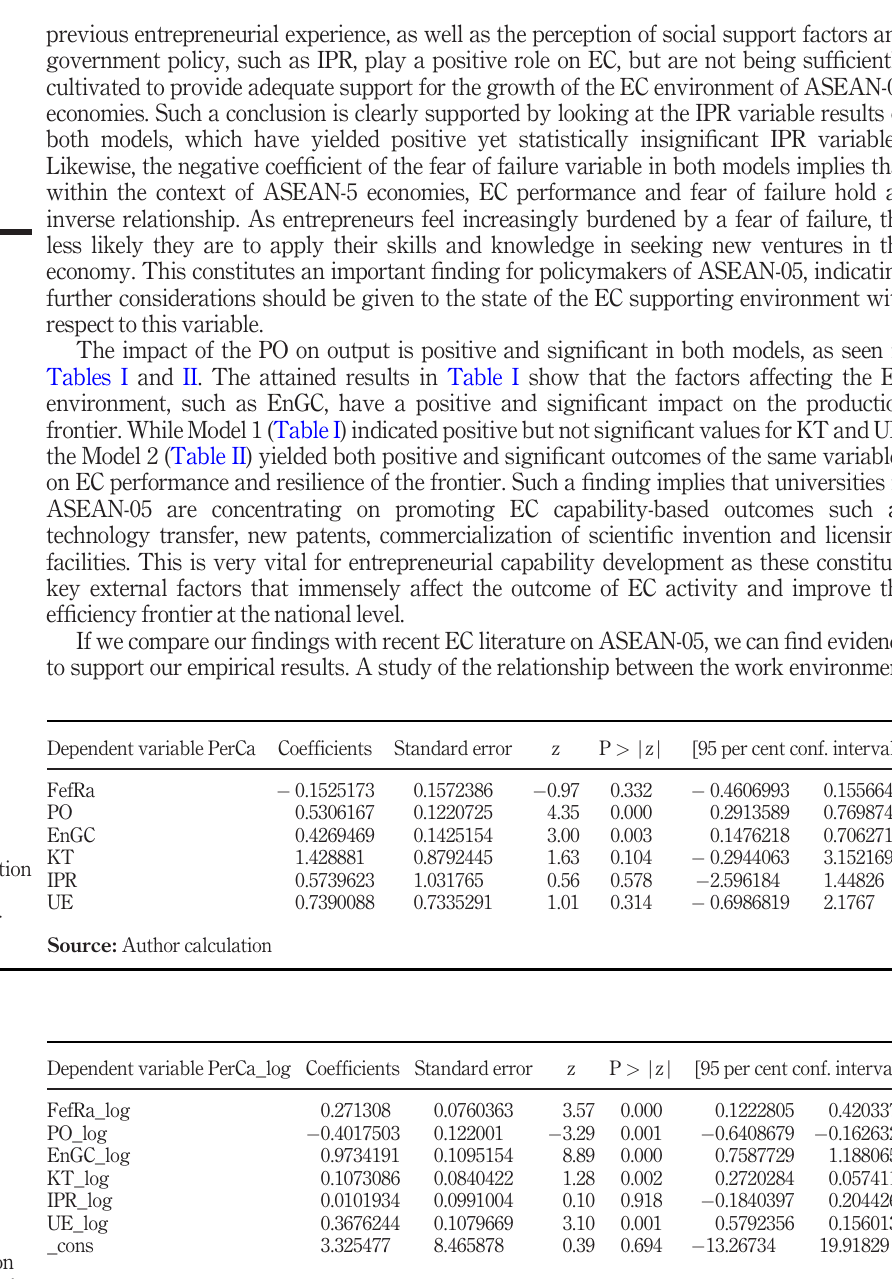
Table II. Log transformation frontier model results